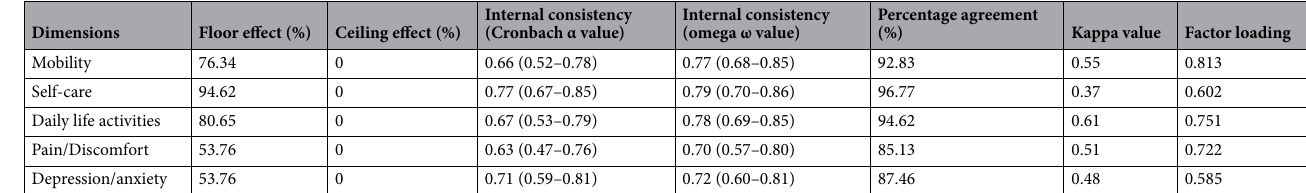
Table 2. Psychometric properties of the EQ-5D-5L questionnaire in COVID-19 survivors experiencing Long COVID. Data from Cronbach α value and omega ω value are mean (95% confidence interval).